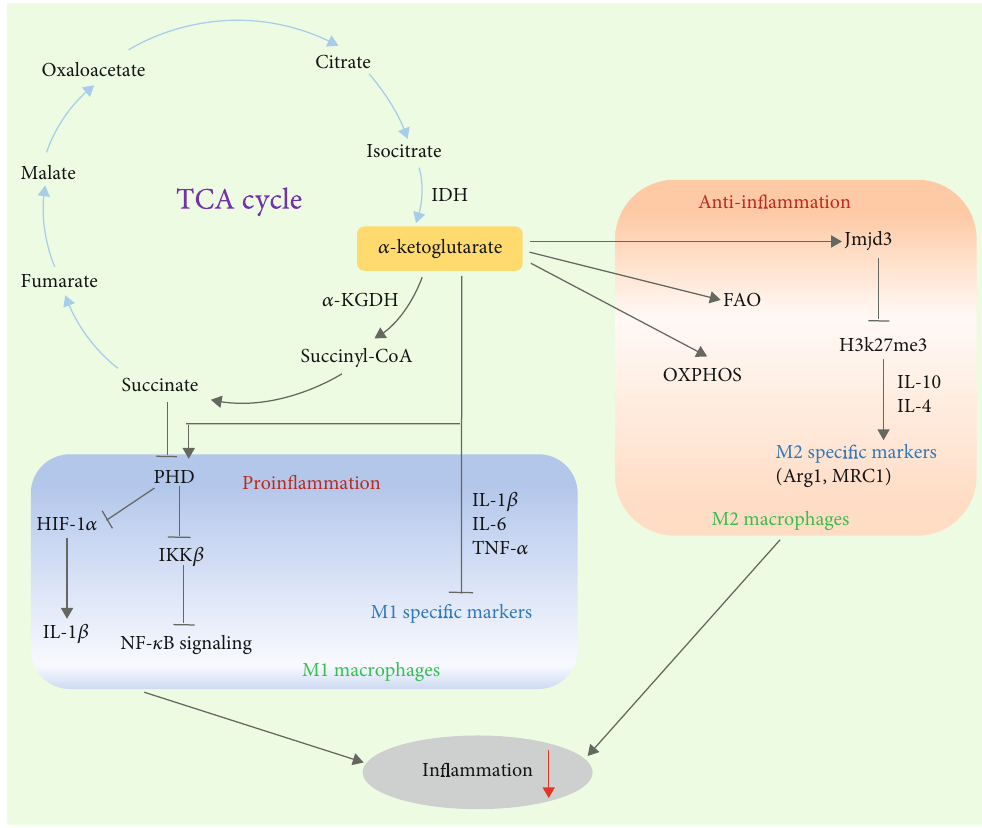
Figure 2: The regulatory mechanism of α -ketoglutarate on M1 and M2 polarization. In M1 macrophages, α -ketoglutarate inhibits M1 polarization by enhancing PHD activity to suppress IKK β activation and the NF- κ B pathway and inhibiting HIF-1 α and IL-1 β expression mediated downstream of succinate in the TCA cycle. In M2 macrophages, α -ketoglutarate generated by glutaminolysis is a checkpoint that regulates M2 metabolic reprogramming and the participation of FAO and OXPHOS in M2 macrophages. Additionally, α -ketoglutarate promotes M2 activation through the α -ketoglutarate-Jmjd3 pathway by suppressing H3K27me3 and increasing the expression of M2- speci fi c